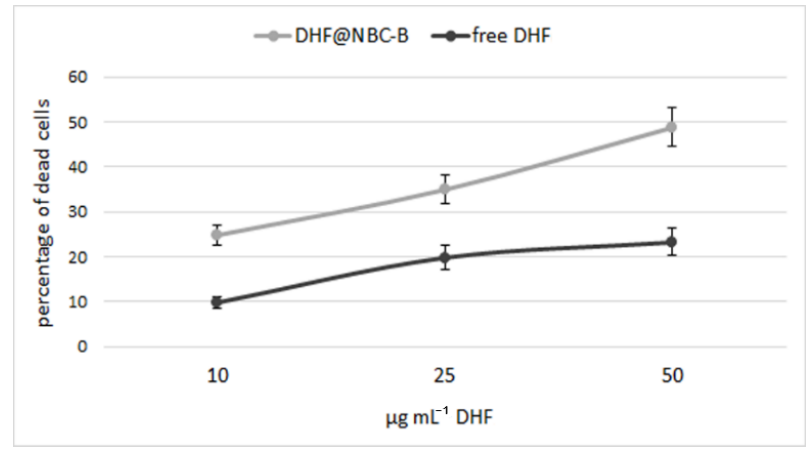
Figure 12. Percentages of dead cells grown in presence of free DHF and of the DHF@NBC-B nanosystem in A549 cells treated for 24 h at the concentrations of the nanosystem corresponding to 10, 25 and 50 µg mL − 1 of the DHF@ alone. Each value represents the mean (±SD) of the experiments made in triplicate for each cell line.